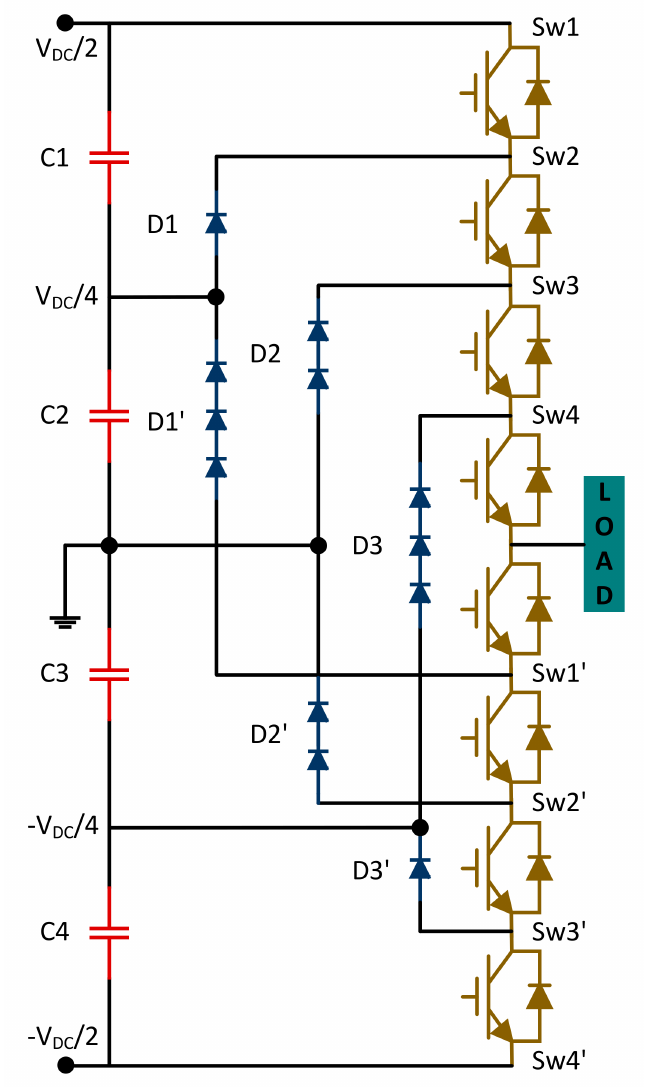
Figure 4. Topology of neutral point clamped multilevel